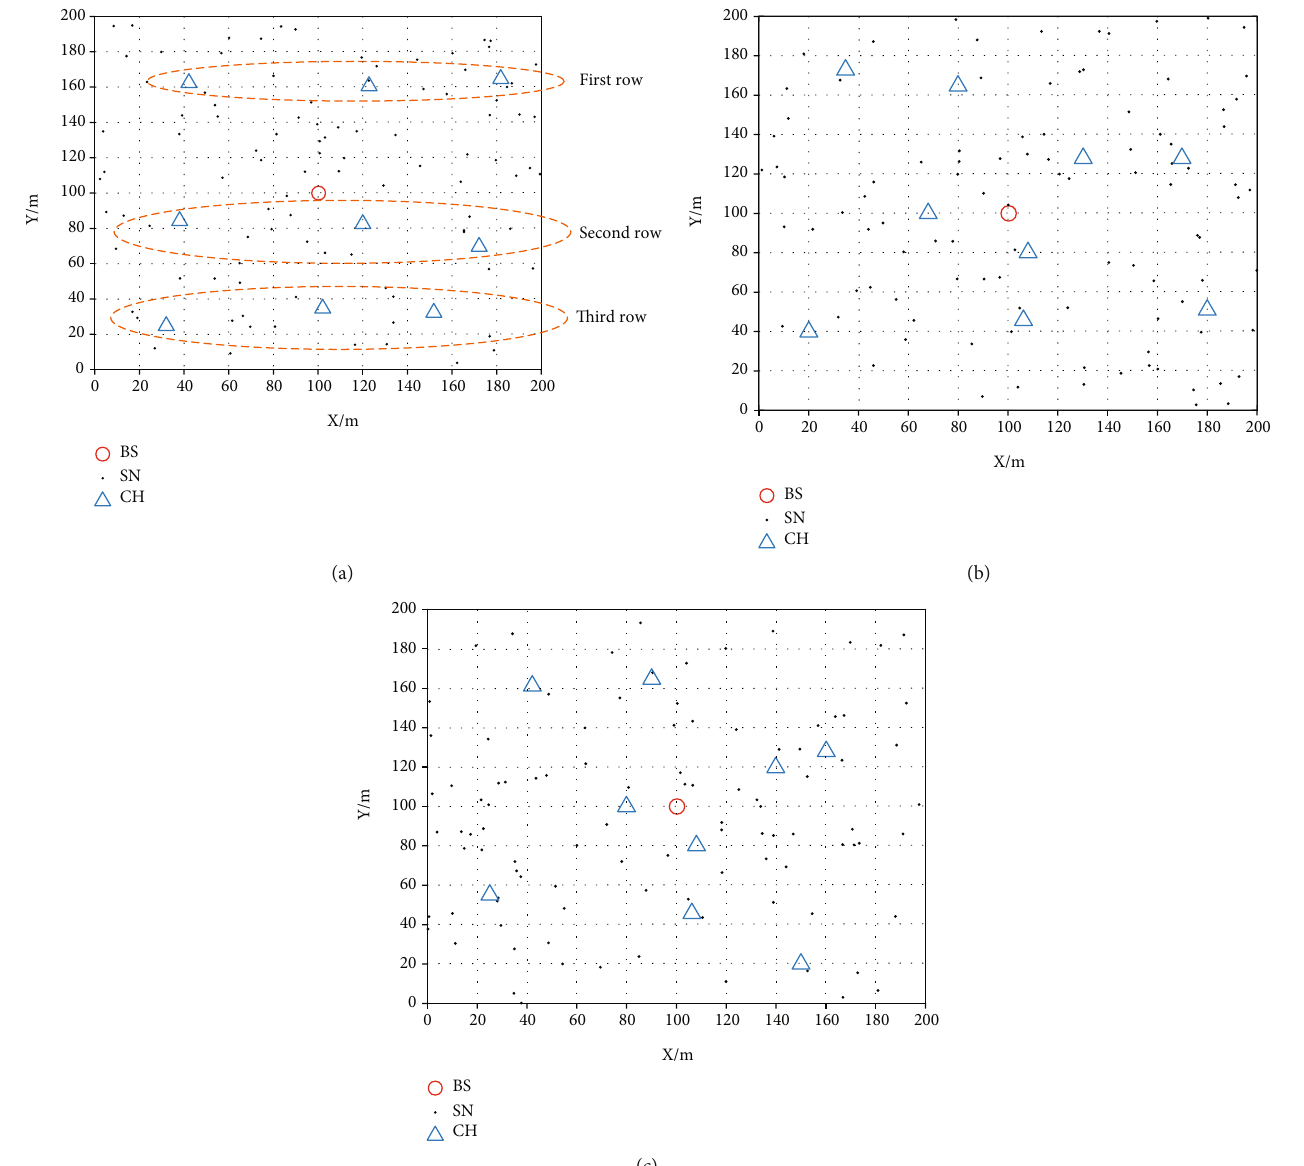
Figure 10: Performance analysis in terms of distribution of